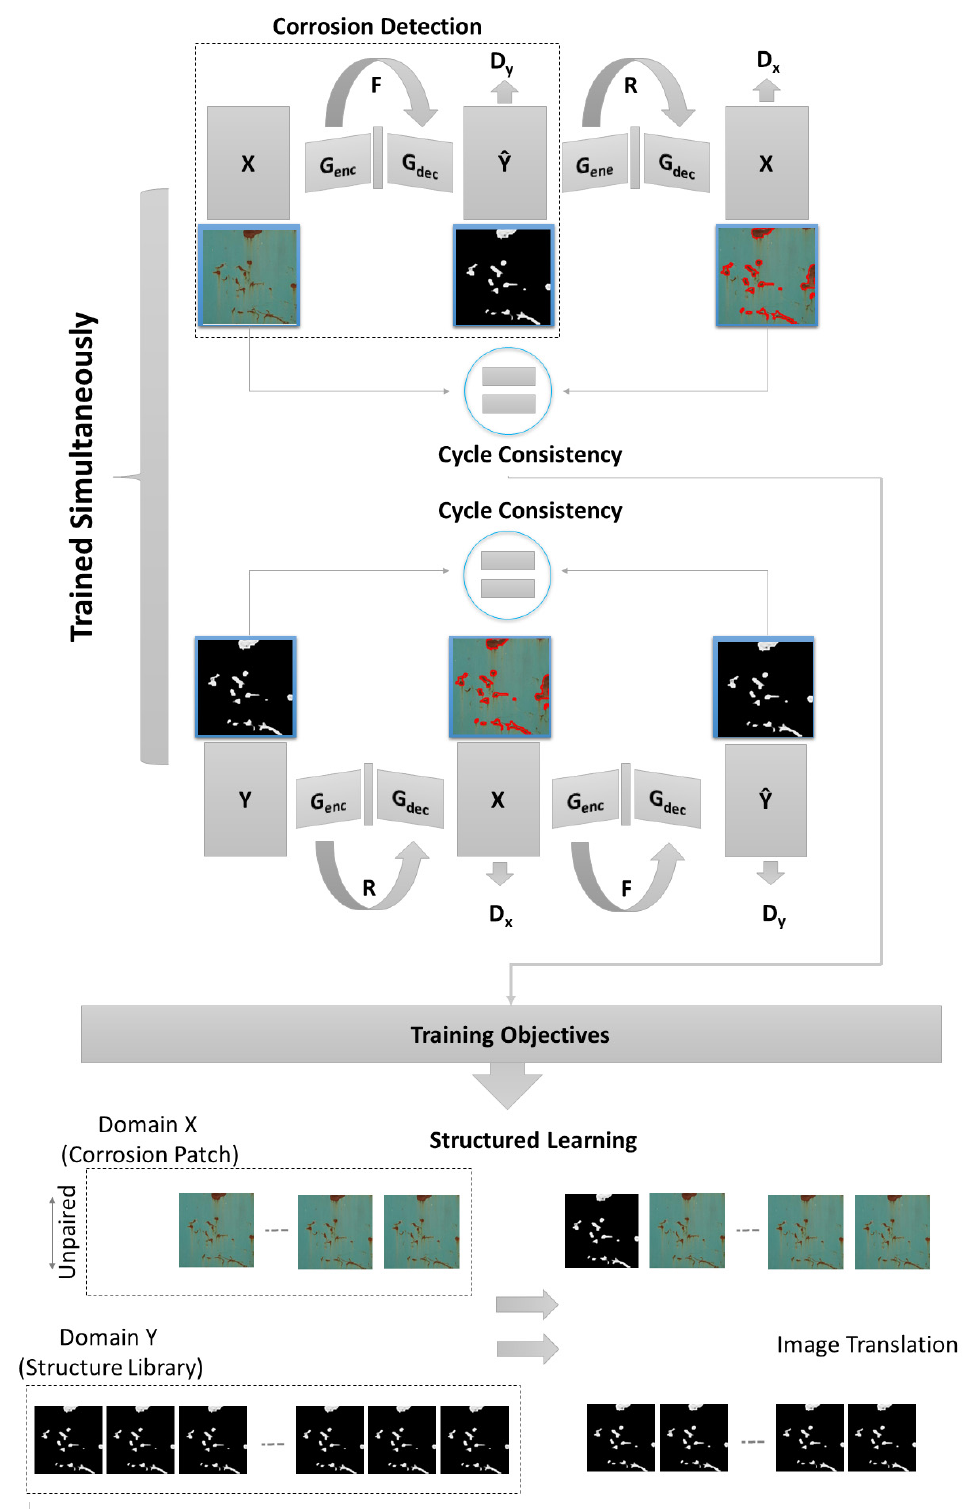
Figure 7. Use of CycleGan for training the network.